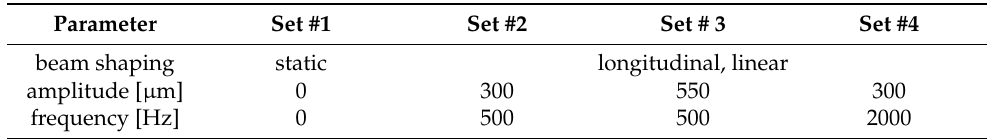
Table 1. Overview of the analyzed sets of static beam shaping and longitudinal, linear beam oscilla-